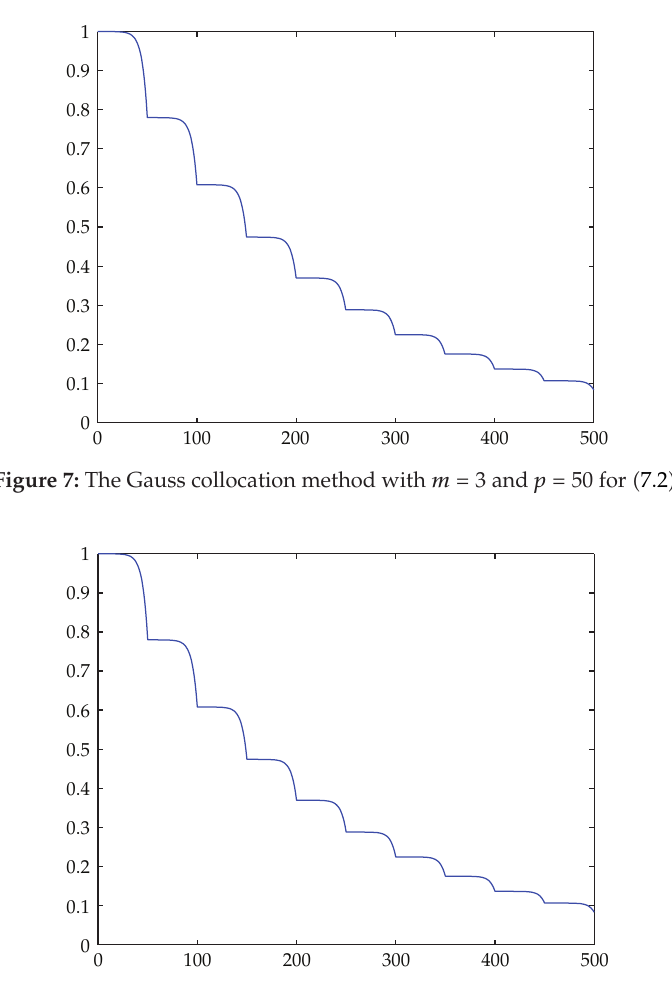
Figure 8: The Radau IIA collocation method with m (cid:4) 3 and p (cid:4) 1000 for (cid:2) 7.2 (cid:3)